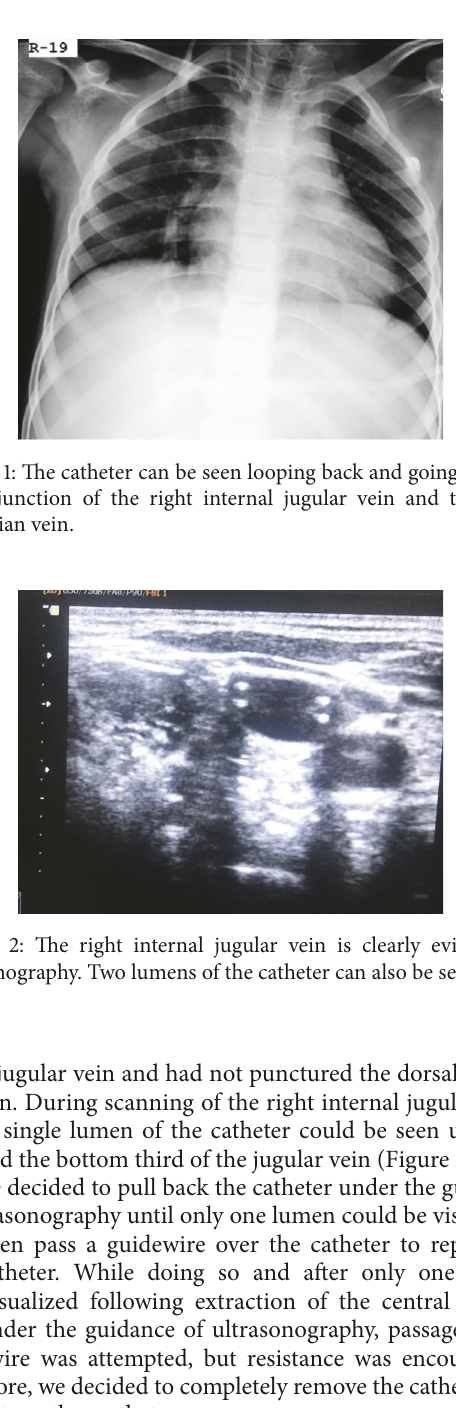
in the jugular vein and had not punctured the dorsal wall of the vein. During scanning of the right internal jugular vein, only a single lumen of the catheter could be seen until we scanned the bottom third of the jugular vein (Figure 2).